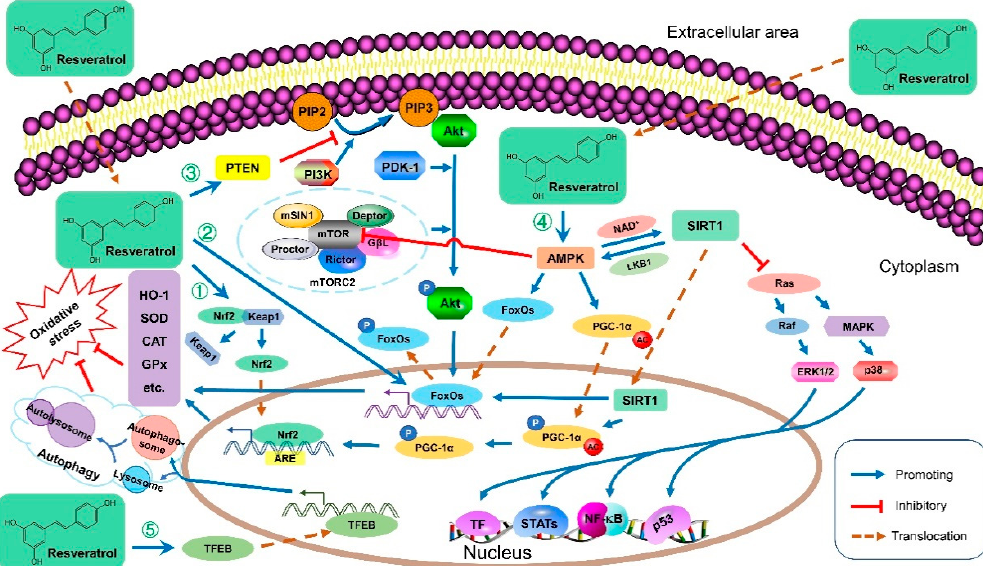
Figure 1. The antioxidant molecular mechanisms of resveratrol. ① Resveratrol unanchors Nrf2 in the cytoplasm, disrupting its Keap1-dependent ubiquitination and degradation. The built-up Nrf2 translocates into the nucleus, binds to ARE, and initiates the transcription of many antioxidative genes such as SOD and CAT to reduce oxidative stress. ② Resveratrol promotes the transcriptional functions of FoxOs in the nucleus to facilitate the transcription of many antioxidative genes like HO-1, contributing to the reduction of oxidative stress. ③ Resveratrol upregulated PTEN, a major antagonist of PI3K, blocking the Akt activation. Consequently, the activated Akt reduces, leading to decreased FoxOs phosphorylation. Therefore, less p -FoxOs translocate from the nucleus to the cytoplasm, and more FoxOs remain in the nucleus to act as transcriptional factors. ④ Resveratrol activates AMPK to maintain the structural stability of FoxOs, facilitate its translocation, and accomplish its transcriptional function. In addition, the activated AMPK phosphorylates PGC-1 α , which can translocate into the nucleus, and be deacetylated by SIRT1. Then PGC-1 α promotes Nrf2, leading to increased antioxidative gene expression and then reduced oxidative stress. Resveratrol activates AMPK, leading to SIRT1 activation, which inhibits MAPK signaling pathways and results in autophagy. ⑤ Resveratrol induces autophagy by activating TFEB, which promotes the formation of autophagosome and lysosome as well as their fusion into an autolysosome, leading to reduced oxidative stress.